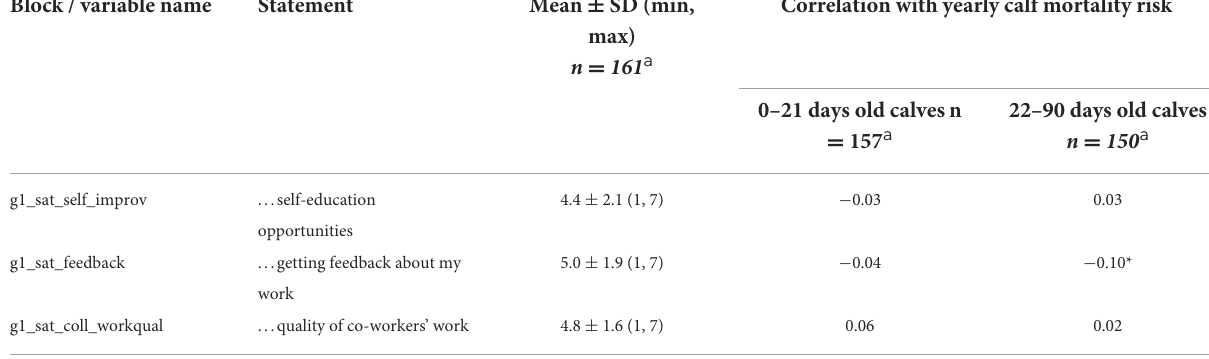
(Figure 1). Herd-level calf mortality risk of calves up to 21